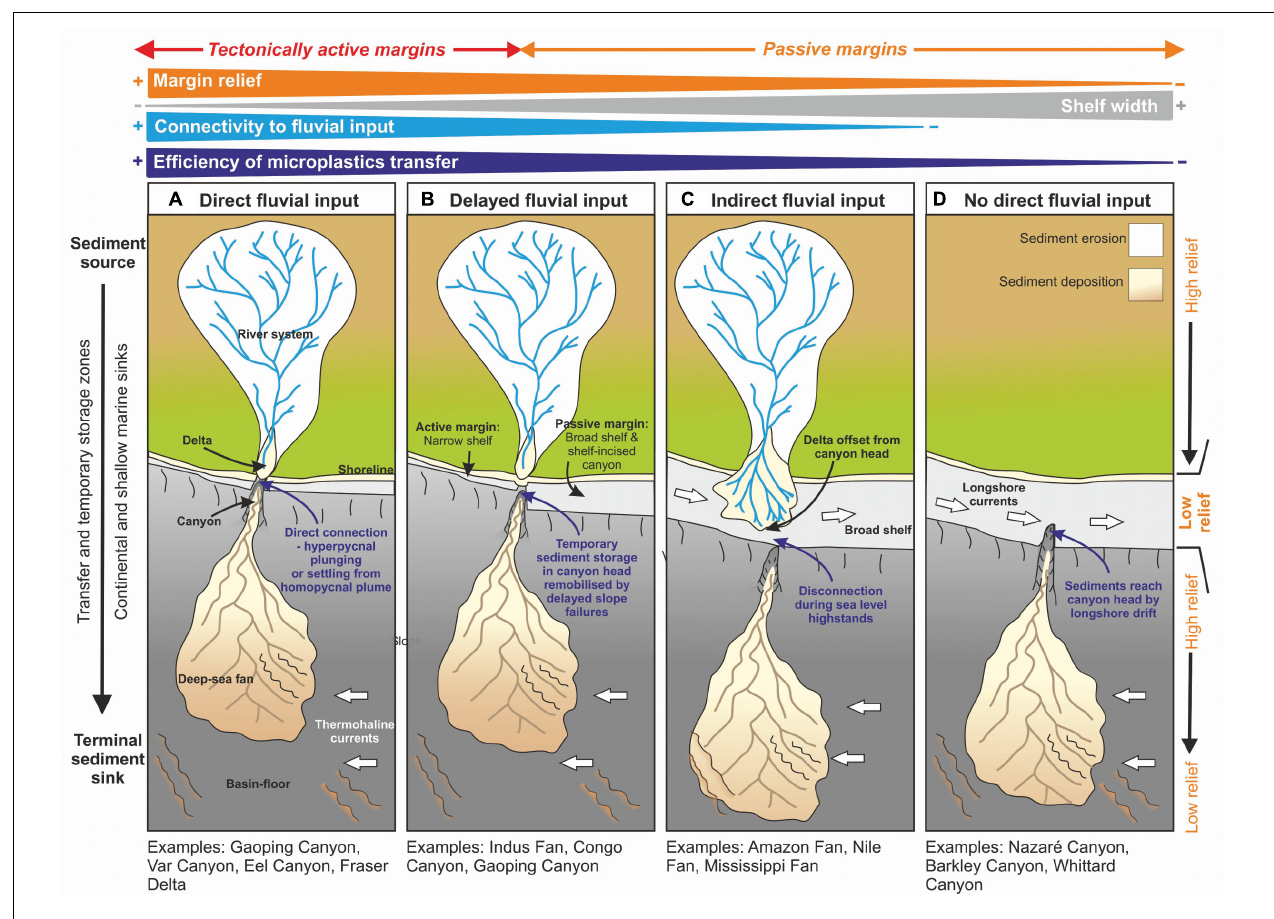
FIGURE 5 | The efficiency of transfer of microplastics and larger primary plastic items from the terrestrial to deep-marine realm is dependent on the duration of onshore sediment storage and the proximity of the canyon head to the principal terrestrial sources of sediment, e.g., river mouths, which is influenced primarily by the tectonic style of the margin. (A) Direct fluvial input to the canyon head, (B) delayed fluvial input as sediment is temporarily stored in the canyon head, (C) indirect fluvial input due to the canyon being offset from the river mouth, and (D) no direct fluvial feeder, sediment is sourced by longshore drift. Longshore currents as well as the volume and density of fluvial outflow will also have a strong influence on the likelihood of plastics reaching the canyon head. Modified from Sømme et al. (2009).